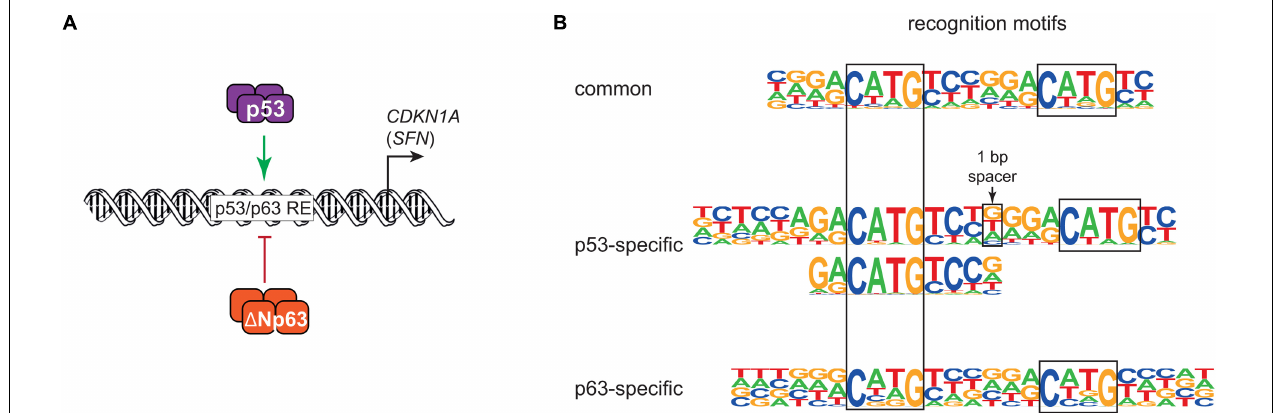
FIGURE 1 | (A) Simplified model of transcriptional repression by (cid:49) Np63 and its dominant negative effect on p53, largely based on Westfall et al. (2003). (B) DNA motifs recognized either by both p53 and (cid:49) Np63 (common) or solely by p53 or (cid:49) Np63. Major motifs taken from Riege et al.